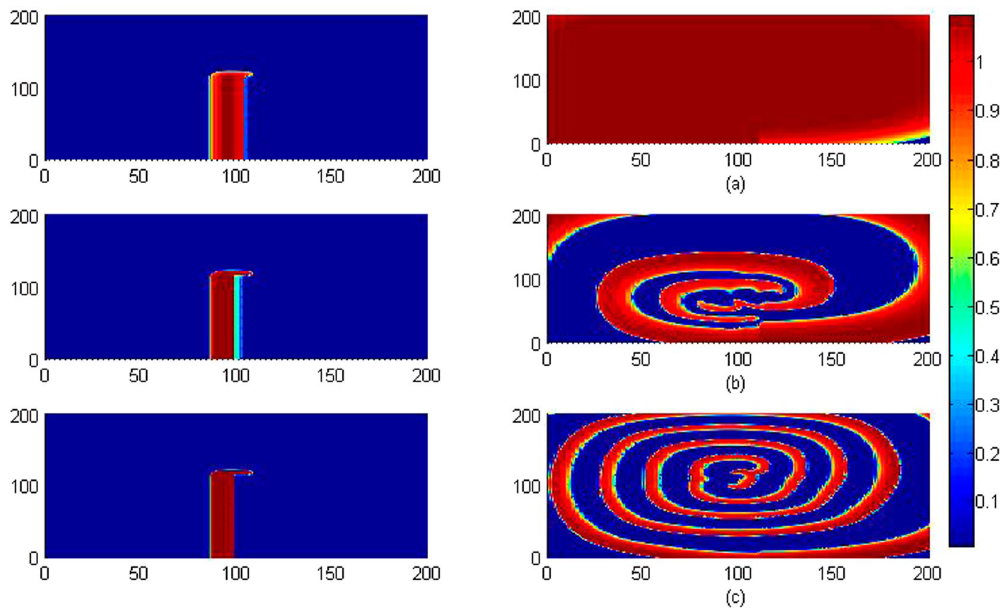
Figure 6. Developed spatial pattern is plotted for the media at t = 10, 200 time units under different feedback gain k 2 , at k 0 = 0.1, k 1 = 0.5, α = 1, β = 2, for ( a ) k 2 = 0.2; ( b ) k 2 = 0.5; ( c ) k 2 = 1.0. The snapshots are shown color